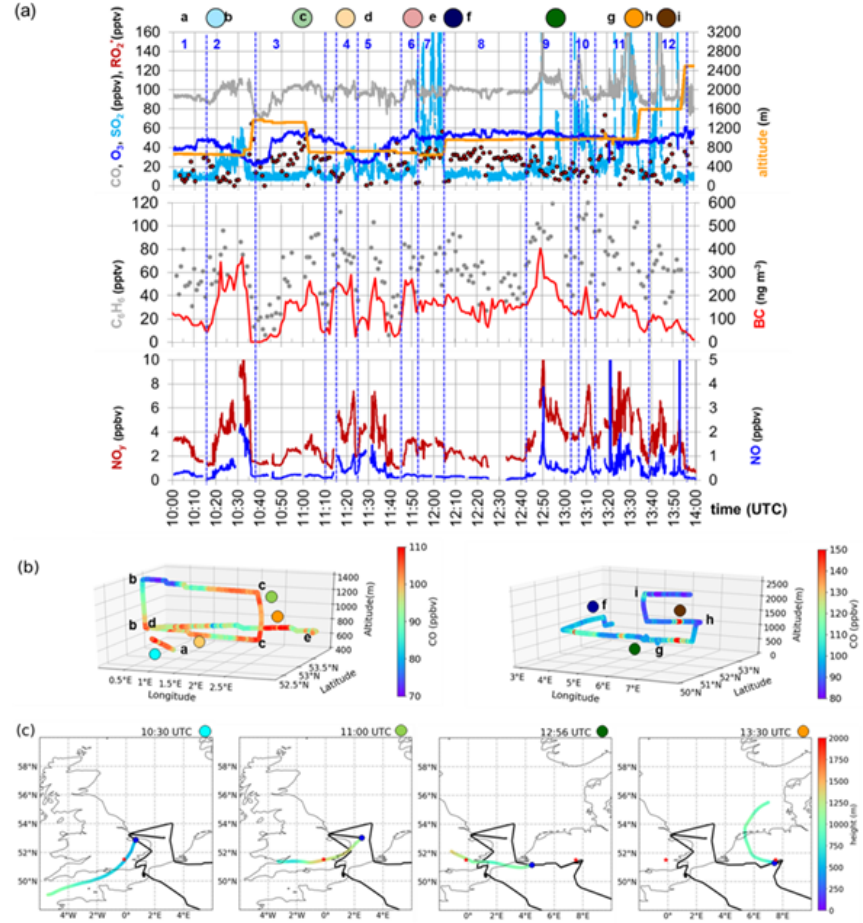
Figure 22. (a) CO, O 3 , SO 2 , RO 2 *, NO y , NO, C 6 H 6 , and BC measured in the outflow of London and BNL during E-EU-08 on 26 July 2017. The position and numbering of the plumes are indicated by blue lines and numbers as classified in Fig. 22 (“B-0” is omitted for clarity) and (b) 3-D shuttles colour coded with the CO mixing ratios observed. Relevant changes in the HALO course and altitude are marked by colour circles and letters (a–i), and (c) selected backward trajectories (24h). The red stars and the blue dot indicate the position of the MPCs of interest and of HALO,